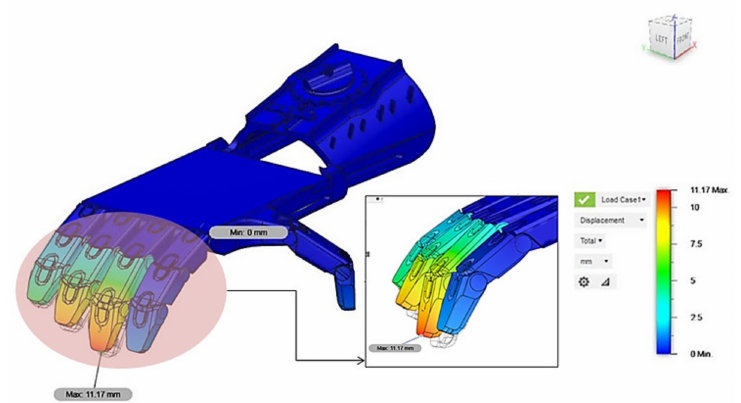
Figure 21. Surface displacement